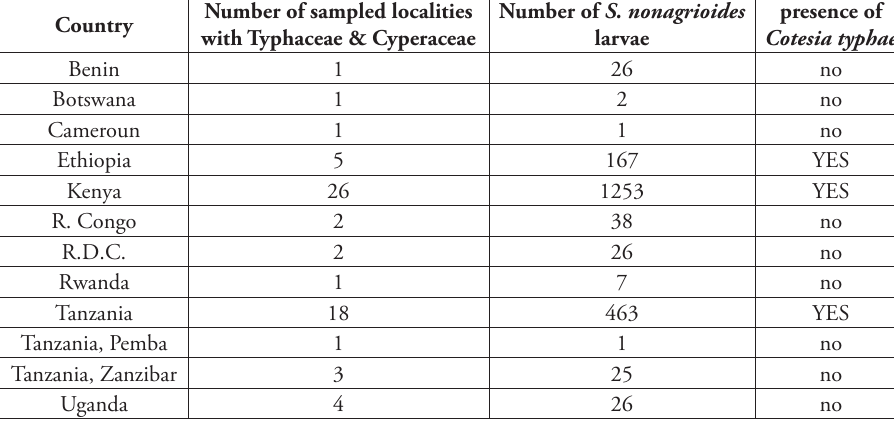
Table 5. Presence of Cotesia typhae in the sampled countries. Results of collections of S. nonagrioides in sub-Saharan Africa from 2004 to 2013. For each country the Table shows the number of localities con- taining Typhaceae and Cyperaceae plants, the total number of S. nonagrioides larvae collected there during the period, and whether some were parasitized by C. typhae . Number of sampled localities Number of S. nonagrioides presence of Country Cotesia with Typhaceae & Cyperaceae larvae